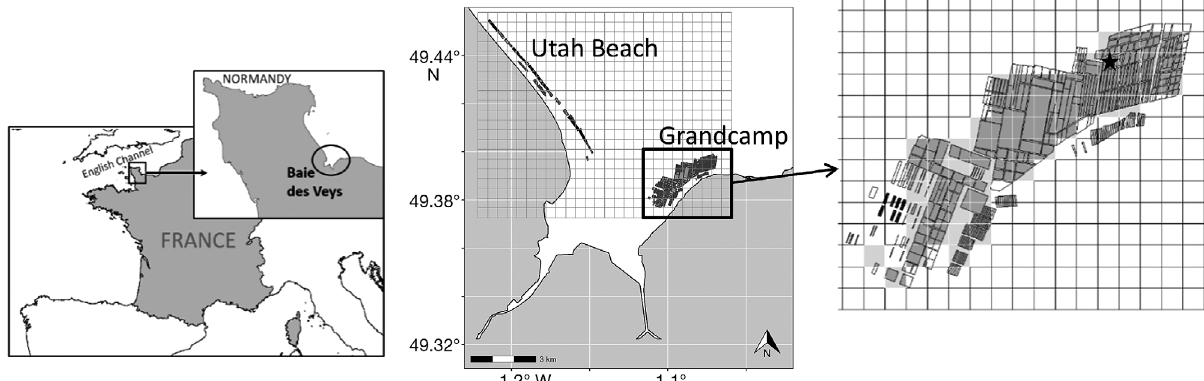
Fig. 1. Location of the study area, Baie des Veys, Normandy, France. The oyster farming zone is indicated by shading and the computation grid. The star indicates the location of patch